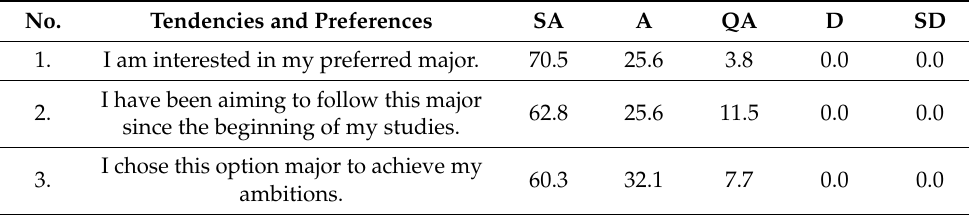
Table 3. Tendencies and Preferences.